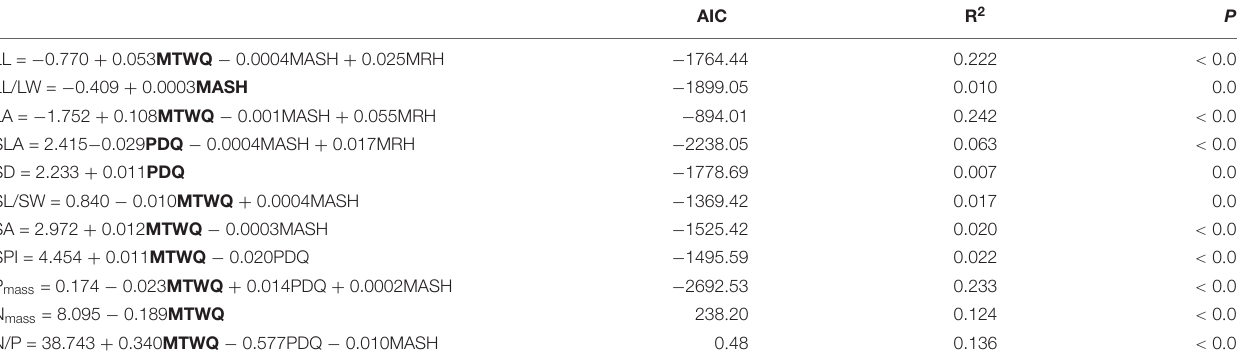
TABLE 3 | Results of multiple linear regressions (MLRs, stepwise model selection routine) for the effects of four main climate predictors on each of eleven leaf traits. AIC R 2 P